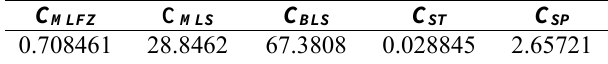
Table 2. Selected value of adjustment parameters of (5) to generate the suitable radiation pattern for GPS receiver C MLFZ